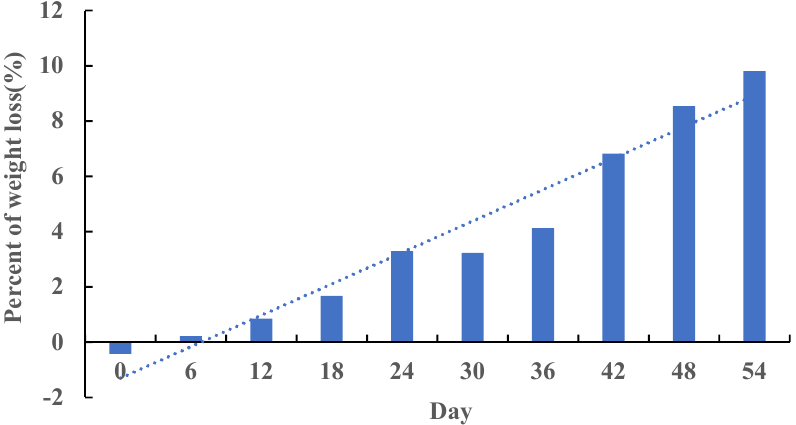
Figure 1. Percentage of weight loss in Group FPD compared with Group HFD. In Group FPD, rats were fed D12492 during the establishment of the obesity model and then fed an FP-containing diet; in Group HFD, rats were fed D12492 during the establishment of the obesity model and then fed AIN-93M.